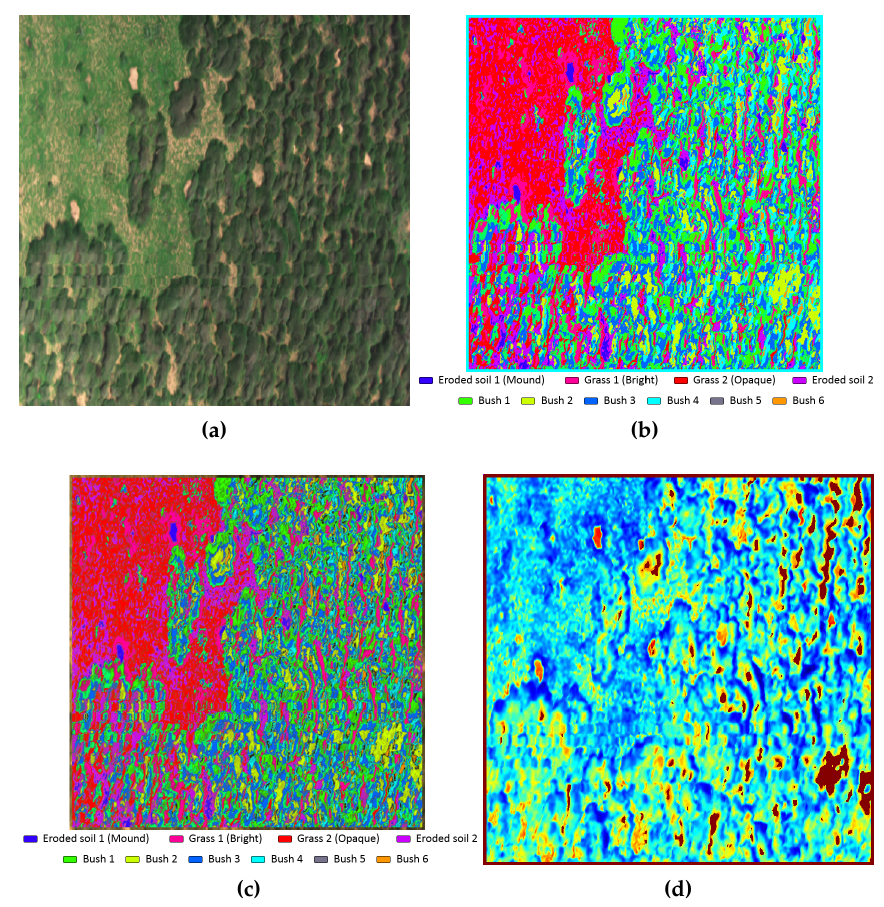
Figure 8. Classification algorithm outputs ( a ) Demonstrative ROI in RGB colour. ( b ) SVM output. ( c ) Linear Spectral Unmixing (LSU) output ( d ) PCA output in false